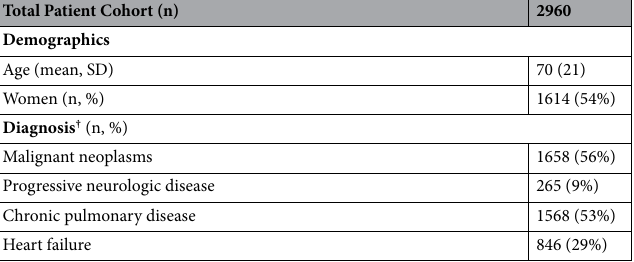
Total Patient Cohort (n)